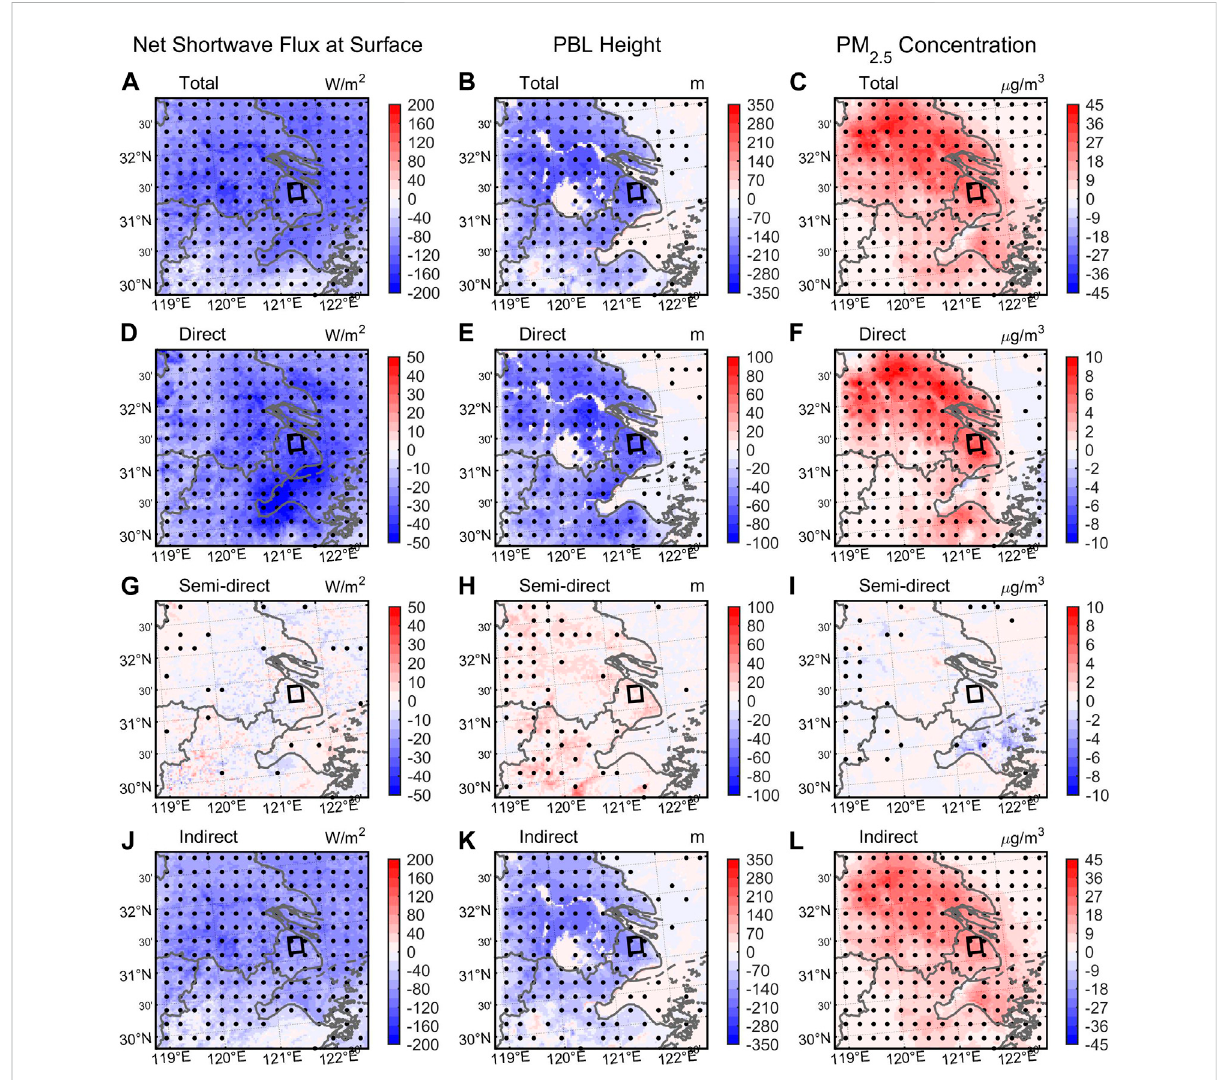
FIGURE 4 Spatial distribution of ensemble mean aerosol effect on net shortwave fl ux at surface (left column), PBL height, (middle column), PM2.5 concentration (right column) in the Shanghai Case, averaged from 7:00 to 17:00 LT. (A – C) The total effect, calculated as BASEreal minus CDNC20. (D – F) The direct effect, calculated as AeroRadoff_int minus AeroRadoff. (G – I) The semi-direct effect, calculated as BASE300 minus AeroRadoff_int. (J – L) The indirect effect, calculated as BASEprogn minus CDNC20. Stilted grids indicate signi fi cant differences at the 5% signi fi cance level. The box regions in the city center are used for calculating mean values in the horizontal